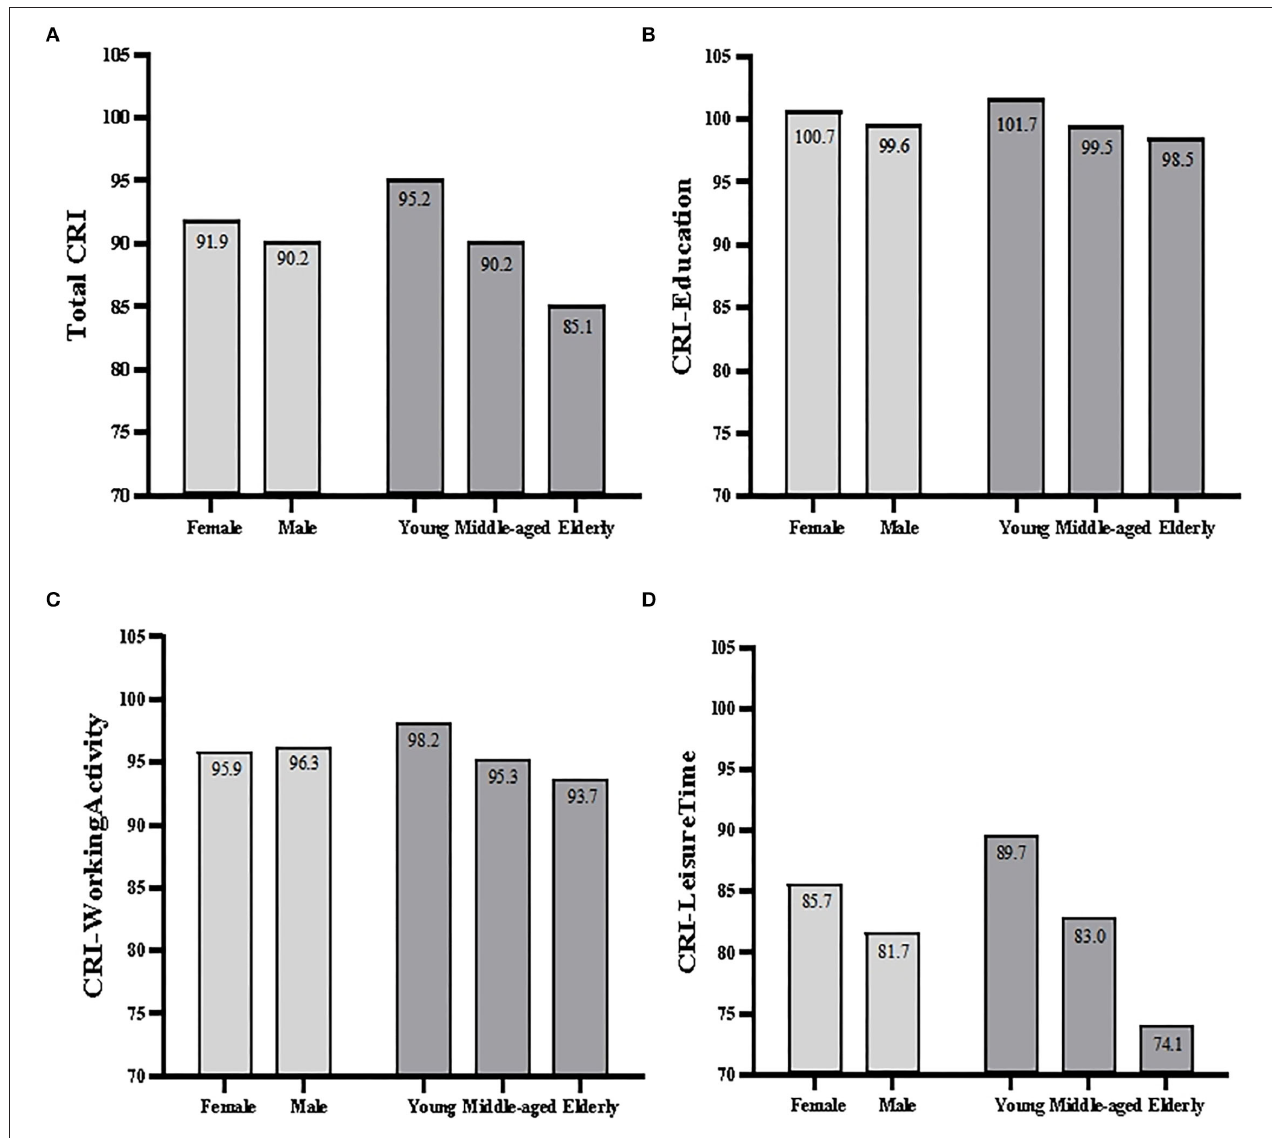
FIGURE 1 | Bar plots of total CRI scores (A) and subscores across gender and age-groups (B–D)